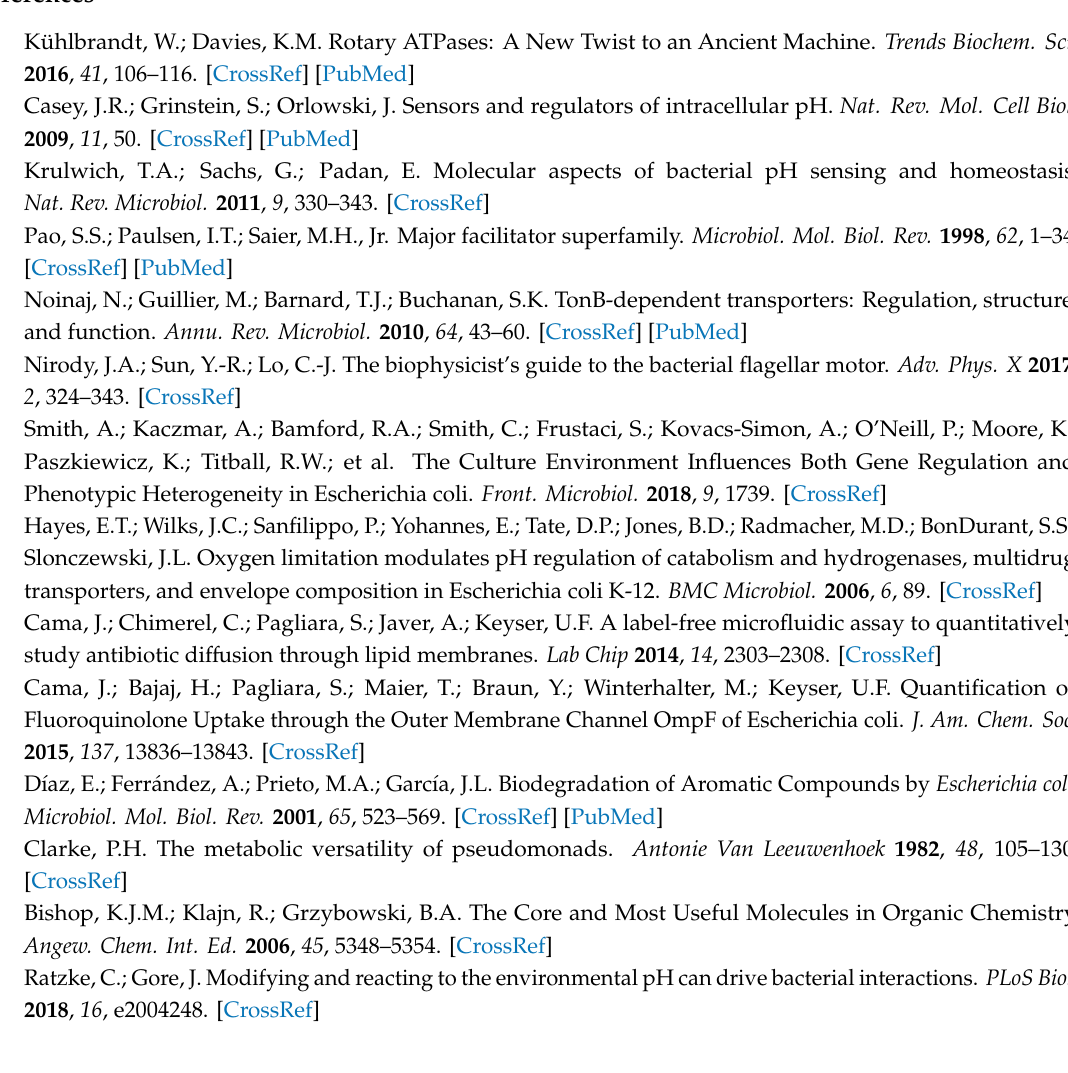
Table S1: Normalized